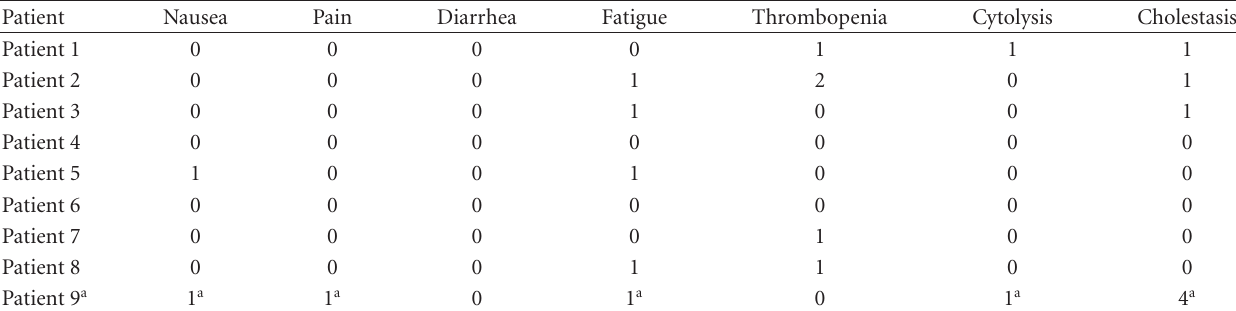
a Symptoms were not related to the HT but most likely to biliary stent obstruction with cholangitis, which is a major concern in cholangiocarcinoma